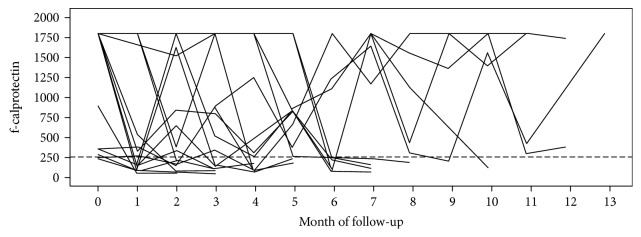
The figure demonstrates how the f-calprotectin levels evolved within each study participant during the study period. Broken line represents the cut-off of 250 μg/g. Within three months, six patients had values below cut-off. Within six months, 13 patients had values below cut-off. Within 10 months, 16 patients had values below cut-off. The remaining four patients never achieved values below cut-off.